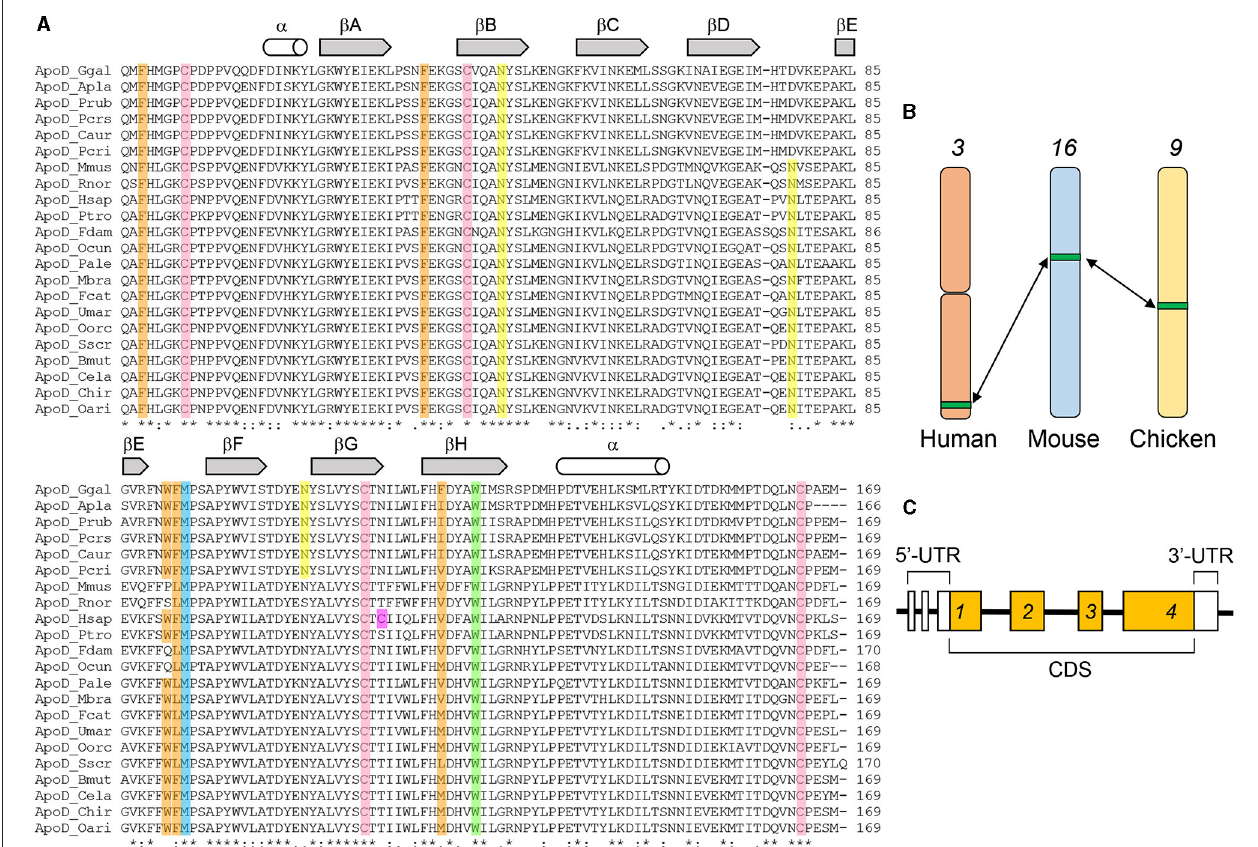
FIGURE 2 | ApoD protein sequence and gene features. (A) Multiple sequence analysis (MSA) of the mature amino acid sequence of selected vertebrate species recovered from GenBank (Apla, Anas platyrhynchos_EOB05196.1; Caur, Cathartes aura_KFP53002.1; Ggal, Gallus gallus_NP001011692.1; Pcri, Pelecanus crispus_KFQ60274.1; Pcrs, Podiceps cristatus_KFZ69168.1; Prub, Phoenicopterus ruber_KFQ85568.1; Bmut, Bos mutus_ELR54927.1; Cela, Cervus elaphus_ABB77207.1; Chir, Capra hircus_XP005675150.1; Oari, Ovis aries_XP004003075.1; Sscr, Sus scrofa_XP001926098.2; Fcat, Felis catus_XP006936237.1; Umar, Ursus marinus_XP008706566.1; Oorc, Orcinus orca_XP004278821.1; Mbra, Myotis brandtii_EPQ12038.1; Pale, Pteropus Alecto_XP006906222.1; Ocun, Oryctolagus cuniculus_ NP001075727.1; Hsap, Hoo sapiens_ NP001638.1; Ptro, Pan troglodites_XP516965.1; Fdam, Fukomys damarensis_KFO33128.1; Mmus, Mus musculus_CAA57974.1; Rnor, Rattus norvegicus_NP036909.1). Asterisks represent identical residues in all sequences, and dots/double dots point to similar residues. α -helices and β -strands are shown on top of the MSA, based on the solved tertiary structure of human ApoD. Colored residues are: four conserved cysteines involved in intramolecular disulfide bonds (pink), the human-specific unpaired cysteine (purple), conserved tryptophan residue in the ligand binding pocket (green), two glycosylated Asn residues (yellow), the antioxidant Met residue (blue), and residues in the hydrophobic surface patches at the rim of the binding pocket (orange). (B) Schematic representation of the chromosomal location of ApoD gene in human, mouse and chicken genomes. (C) Schematic representation of a consensus gene architecture for chordate ApoD, with four coding sequence (CDS)-containing exons and several 5 ′ -UTR exons.